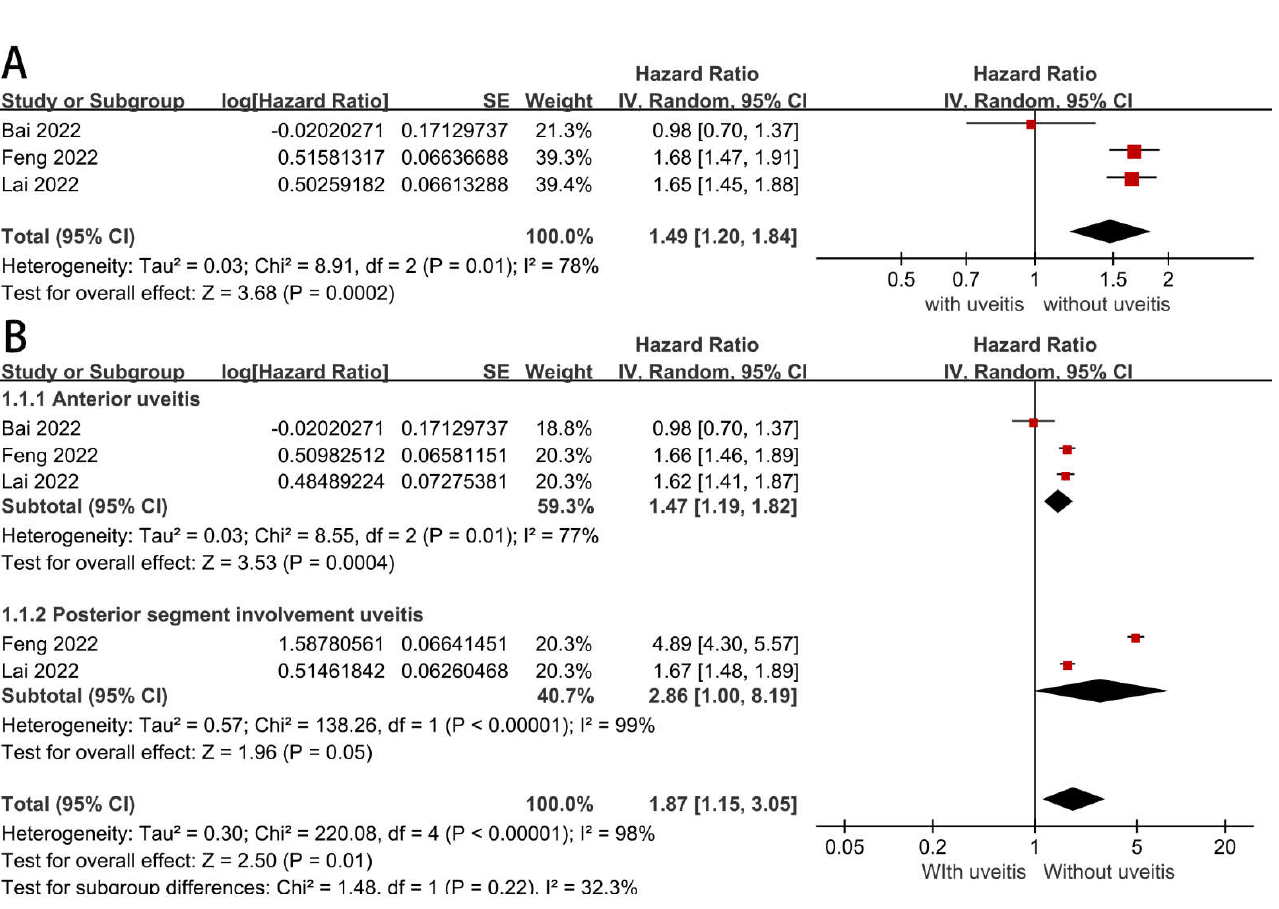
Figure 3. ( A ) Forest plots showing pooled HR with 95% CI of atherosclerosis-related CVD for pa- tients with uveitis versus those without. ( B ) Forest plots showing subgroup uveitis and atheroscle- rosis-related CVD